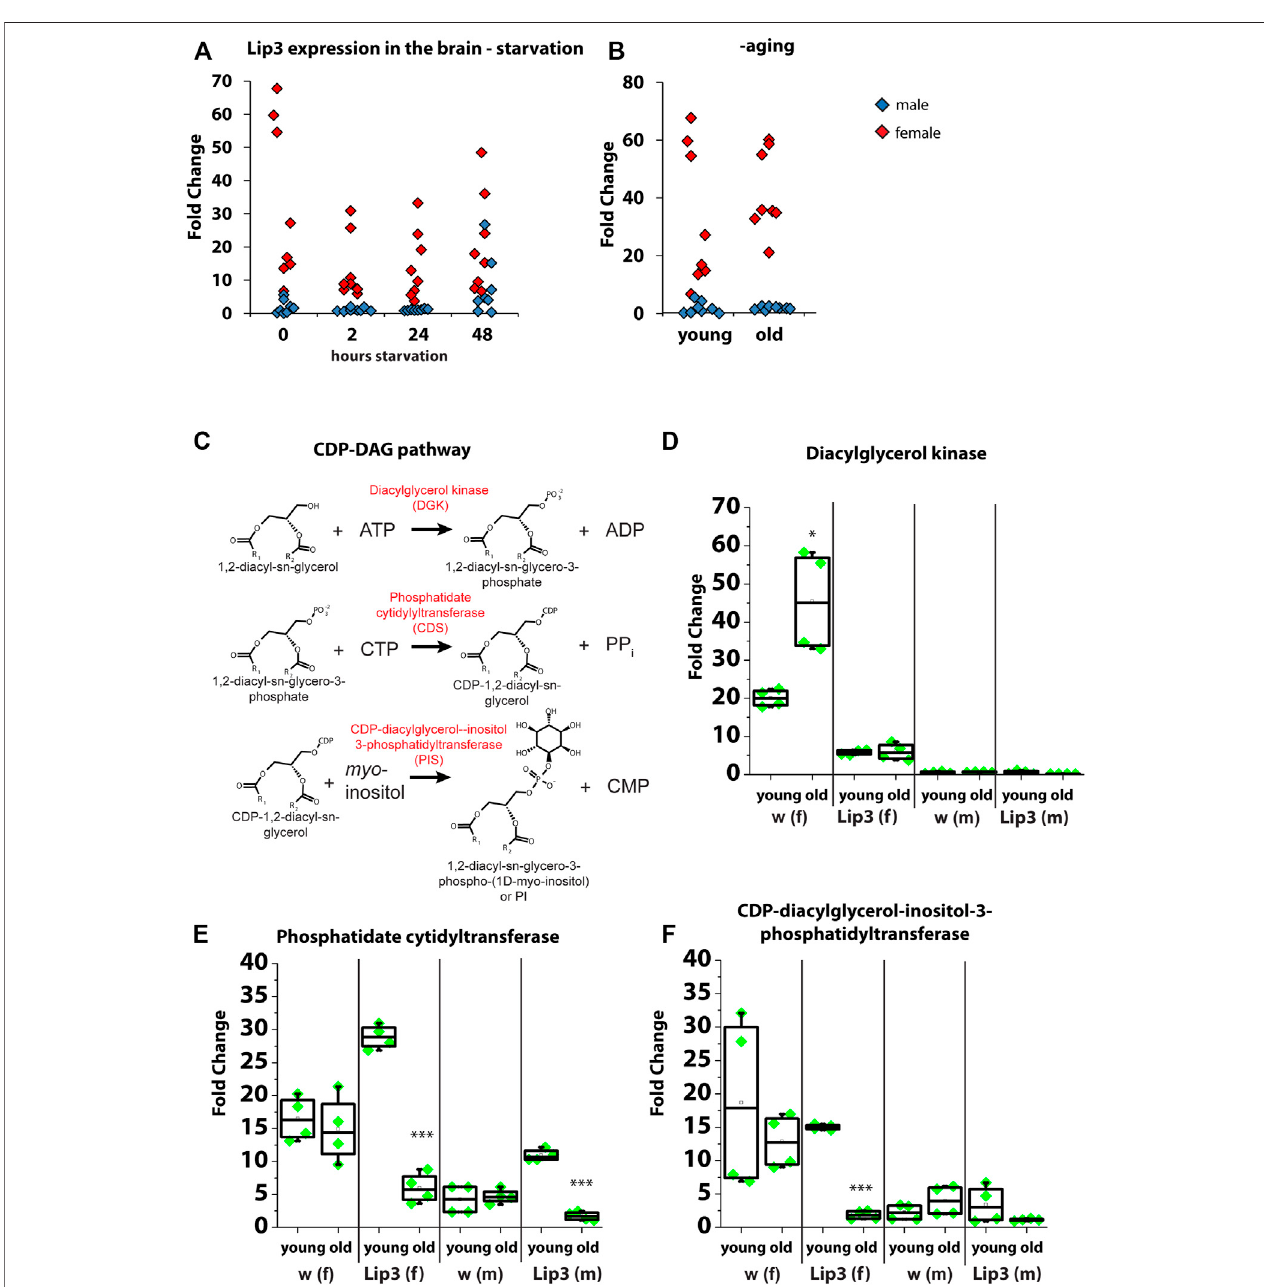
FIGURE 4 | (A) Quantitative real-time PCR of Lip3 transcript in isolated adult brains from fed (0 h) and starved (2, 24, 48 h) male (blue squares) and female (red squares) normalized to rp49 and actin-5c housekeeping genes and relative to whole body from fed male and female fl ies, respectively. (B) Quantitative real-time PCR of Lip3transcriptinisolatedadultbrainsfrommale(bluesquares)andfemale(redsquares) fl ies,normalizedtorp49andactin-5chousekeepinggenesandrelativetowhole bodyfrom 5 day old male and female fl ies,respectively.Datasets forfed fl ies in Aand young fl ies in Bareidentical. (C) Representationofthe CDP-DAG pathway of PIsynthesis. (D) Quantitativereal-timePCRofDAGkinase(Dgk)transcriptinisolatedadultbrains,normalizedtorp49andactin-5chousekeepinggenesandwholebody from 5 day old fl ies (male brains normalized to male whole fl ies and female brains normalized to female whole body). (E) Quantitative real-time PCR of phosphatidate cytidyltransferase (Cds) transcript in isolated adult brains, normalized to rp49 and actin-5c housekeeping genes and whole body from 5 day old fl ies (male brains normalized to male whole fl ies and female brains normalized to female whole body). (F) Quantitative real-time PCR of CDP-diacylglycerol-inositol-3-phosphatidyl- transferase (PIS) transcriptin isolated adult brains, normalized to rp49 and actin-5c housekeeping genes and whole body from 5 day old fl ies (male brains normalized to male whole fl ies and female brains normalized to female whole body). Asterisks represent * p < 0.05, *** p < 0.001.